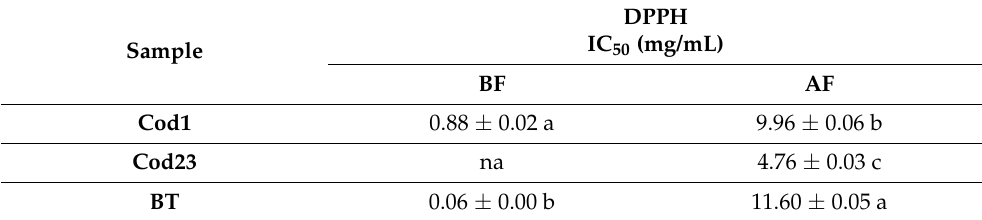
Table 1. Effect of kombucha fermentation on antioxidant activity.